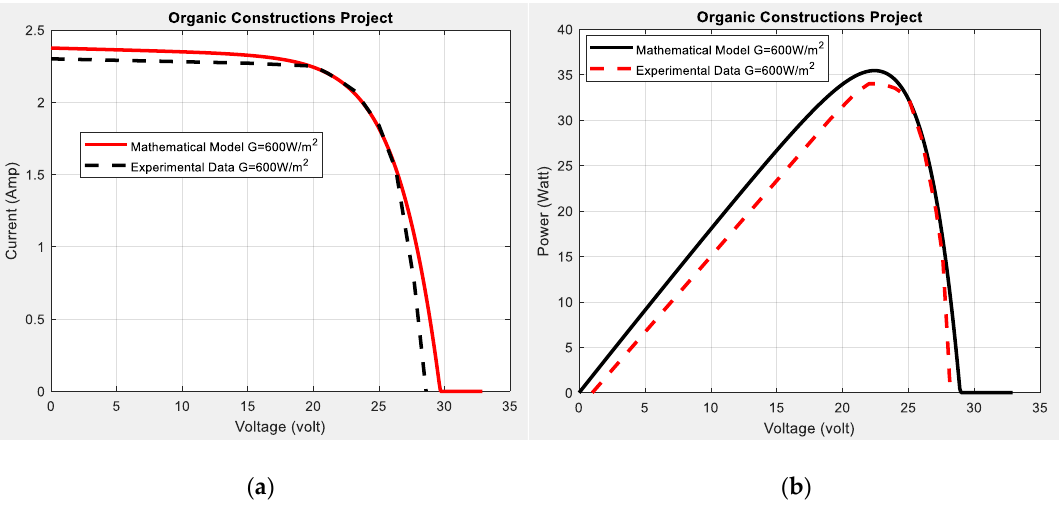
Figure 22. ( a ) Comparison of voltage—current experimental data and mathematical model at 600 W / m 2 . ( b ) Comparison of voltage—power experimental data and mathematical model at 600 W / m 2 .